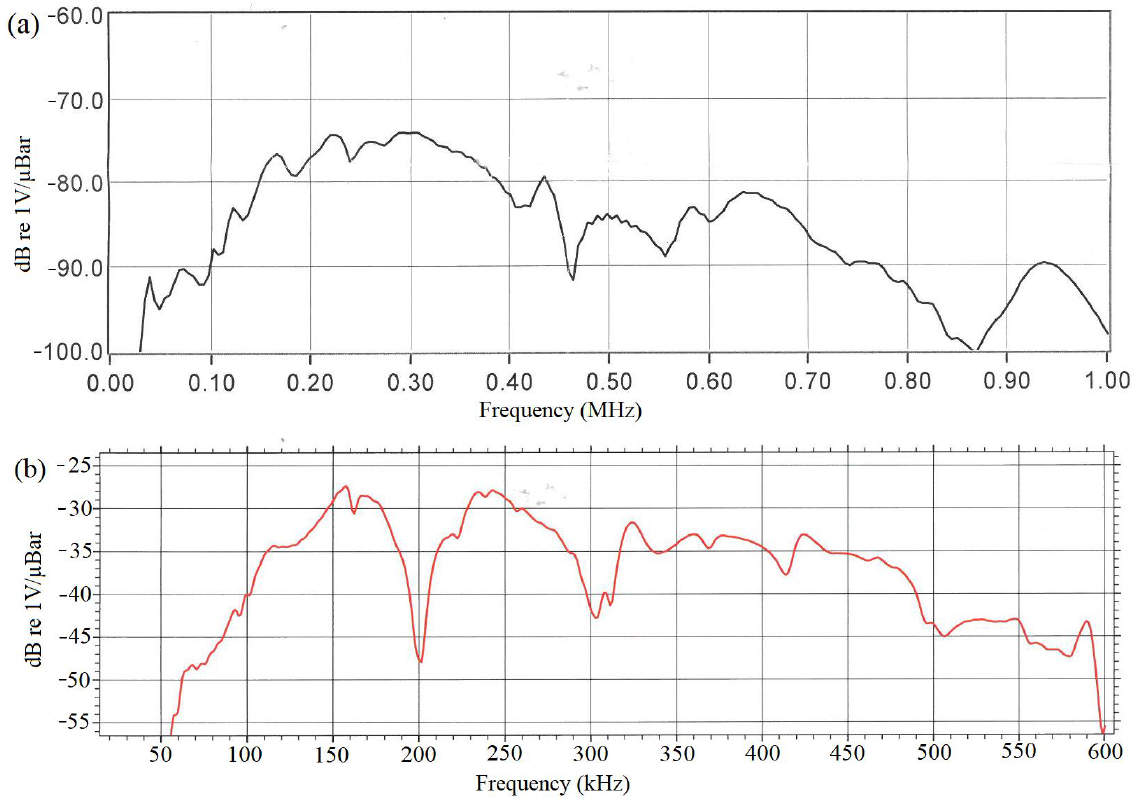
Figure 1. Response curves of two types of sensors used in this study: ( a ) Nano30 [14] and ( b ) VS150- RIC sensors [15] .